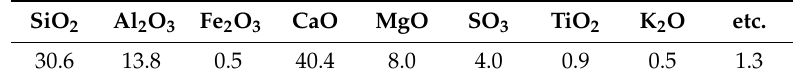
Table 2. Chemical compositions of